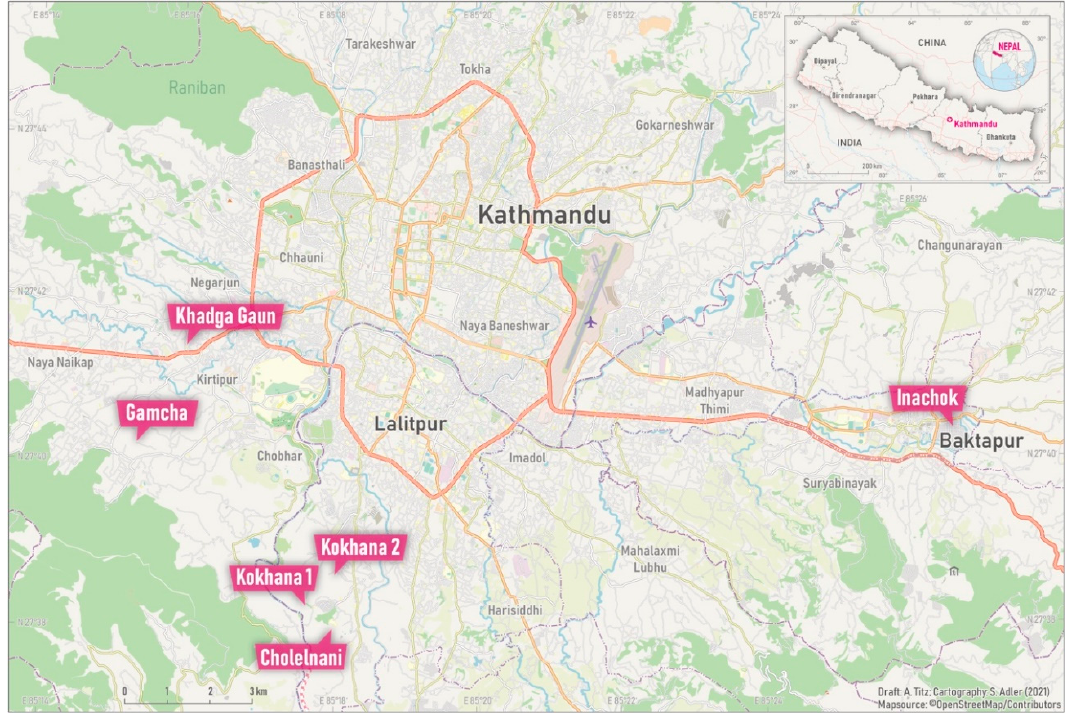
Figure 1. Locations of camps and displacement sites where interviews with internally displaced people (IDPs) were con- ducted.